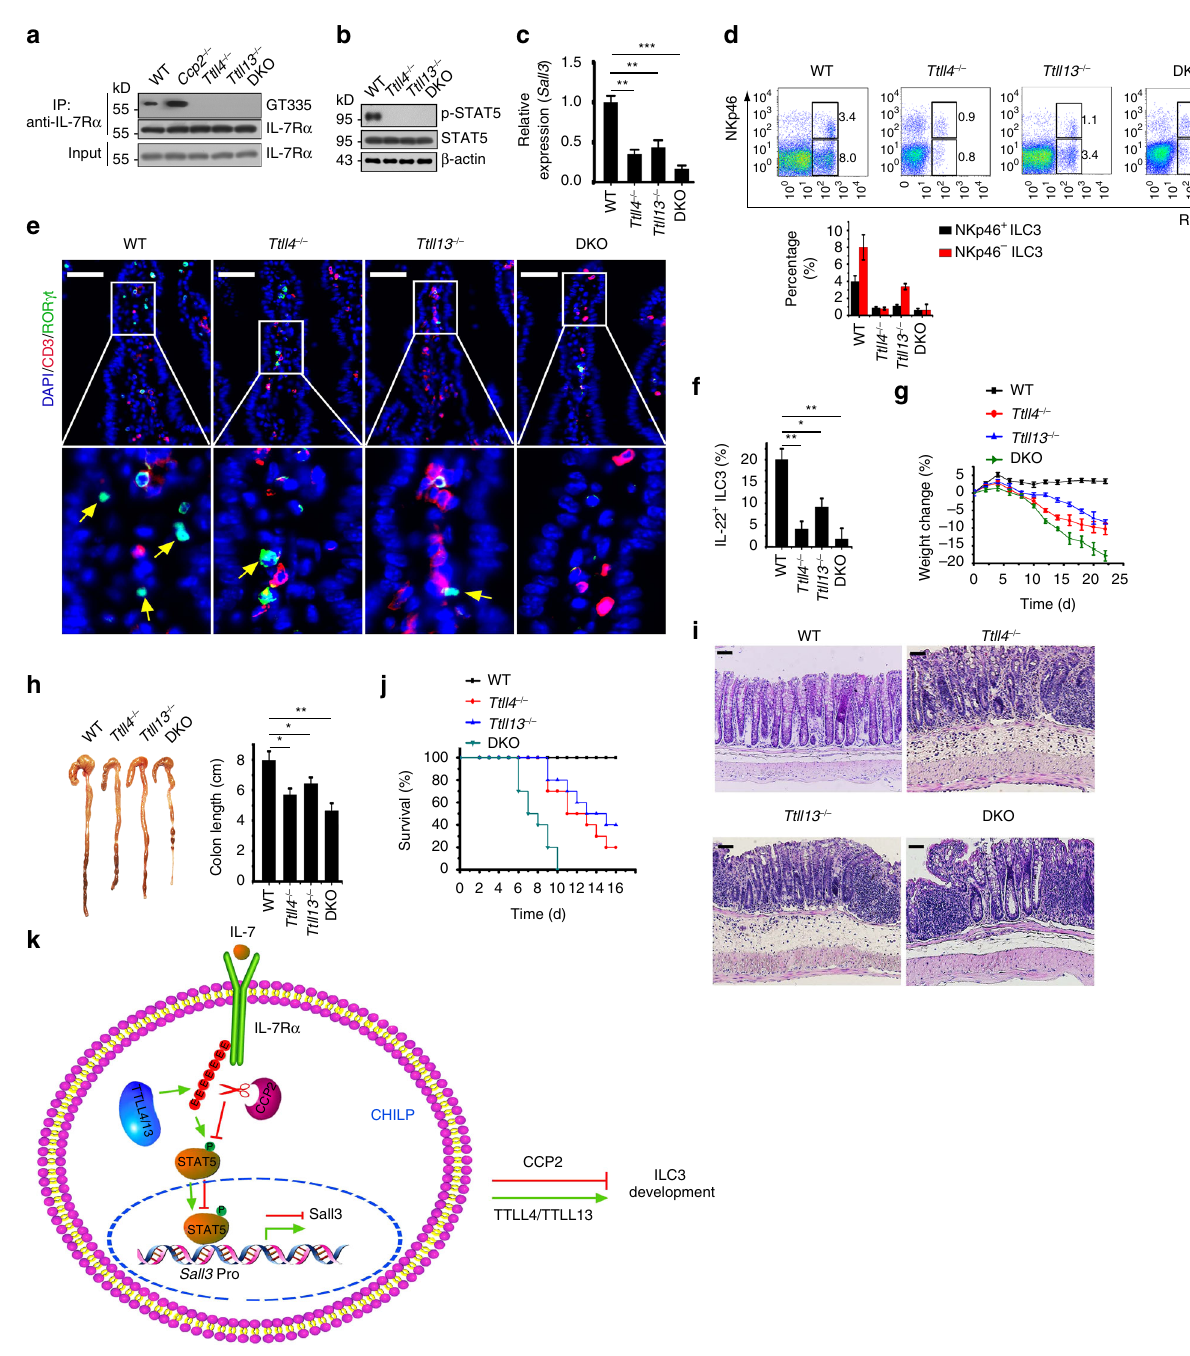
Fig. 6 Deletion of Ttll4 or Ttll13 impairs ILC3 development. a Detection of IL-7R α glutamylation in CHILPs by gating on Lin − IL-7R α + Flt3 − CD25 − α 4 β 7 + from WT, Ccp2 − / − , Ttll4 − / − , Ttll13 − / − , and Ttll4 − / − Ttll13 − / − mice. b Examination of STAT5 phosphorylation in CHILPs from WT, Ccp2 − / − , Ttll4 − / − , Ttll13 − / − . and Ttll4 − / − Ttll13 − / − mice. c Sall3 expression levels were tested in WT, Ttll4 − / − , Ttll13 − / − , and Ttl4 − / − Ttll13 − / − CHILPs by quantitative reverse transcription PCR (RT-qPCR). Relative fold change of Sall3 expression values were normalized to endogenous Actb . d Flow cytometry analysis of ILC3s in small intestine lamina propria from WT, Ttll4 − / − , Ttll13 − / − , and Ttll4 − / − Ttll13 − / − mice. Percentages of indicated cells were calculated and shown as means ± s.d. ( right panel). n = 6 for each group. e Analysis of ILC3s in WT, Ttll4 − / − , Ttll13 − / − , and Ttl4 − / − Ttll13 − / − small intestines by immuno fl uorescence staining in situ. Arrowhead denotes ILC3 cells. Scale bars , 50 μ m. f Analysis of IL-22 + ILC3s after IL23 stimulation by fl ow cytometry. n = 6 for each group. g Body weight changes of WT, Ttll4 − / − , Ttll13 − / − , and Ttll4 − / − Ttll13 − / − mice post C. rodentium infection. n = 10 for each group. h Colon length from WT, Ttll4 − / − , Ttll13 − / − , and Ttll4 − / − Ttll13 − / − mice after C. rodentium infection. n = 6 per genotype group. i Histology of colons from WT, Ttll4 − / − , Ttll13 − / − , and Ttll4 − / − Ttll13 − / − mice 8 days after infection with C. rodentium . Scale bars , 50 μ m. j Survival curves of WT, Ttll4 − / − , Ttll13 − / − , and Ttll4 − / − Ttll13 − / − mice after C. rodentium infection. n = 10 for each group. In all, 2 × 10 9 C. rodentium was used by oral inoculation. k A working model represents glutamylation-mediated IL-7 signaling in the regulation of ILC3 development. Pro promoter. * P < 0.05, ** P < 0.01, and *** P < 0.001 (Student ’ s t -test). Data represent three independent experiments. Error bars in c , d , and f – h indicate